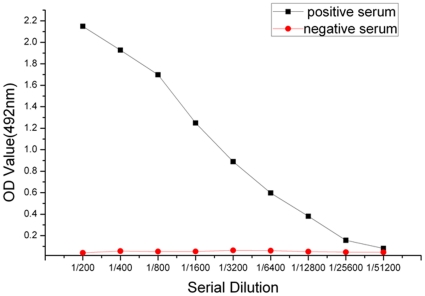
Determine of polyclonal antibody titer by ELISA.ELISA was used to determine the following ratio for antibodies against rBmTHY: positive serum extinction value/negative serum extinction value (P/N)≥2.1 was positive; 1.5≤P/N<2.1 was suspicious expression; P/N<1.5 was negative. From this, the titer of the antibodies was greater than 1∶25600 at a concentration of 10 µg/mL.